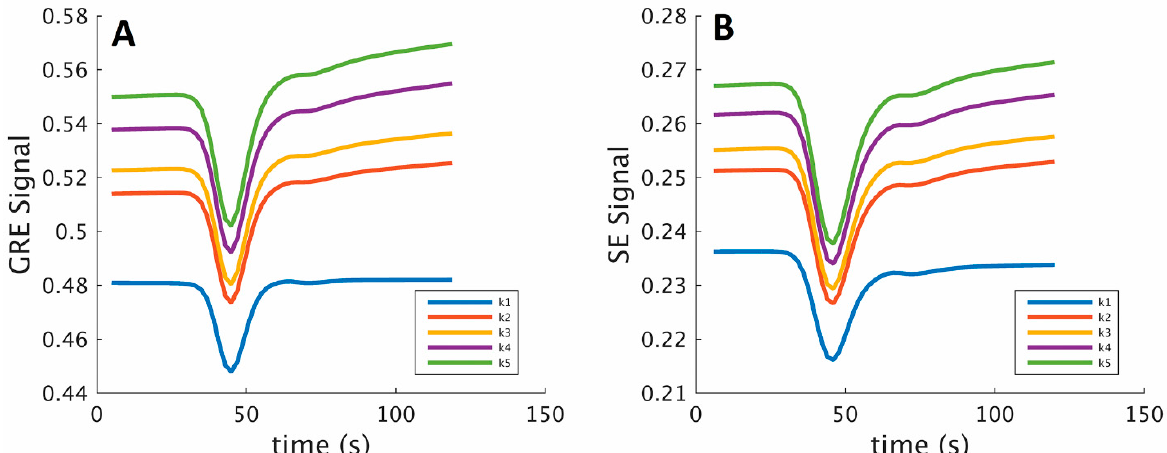
Figure 2. GRE ( A ) and SE ( B ) signals for 5 atoms from the simulated dictionary for different perme- abilities, k (k1 = 0, k2 = 0.3 × 10 − 3 s − 1 , k3 = 0.4 × 10 − 3 s − 1 , k4 = 0.6 × 10 − 3 s − 1 , k5 = 0.8 × 10 − 3 s − 1 ) and a fixed vessel radius (R = 87 μ m) and relative cerebral blood volume (rCBV = 4.6%) during the bolus injection, after the preload.